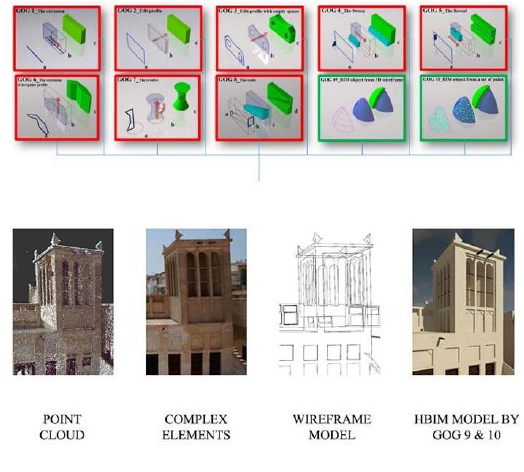
Figure 5. The second step based on GOG 9 and GOG 10 allows the generation of complex heritage elements using